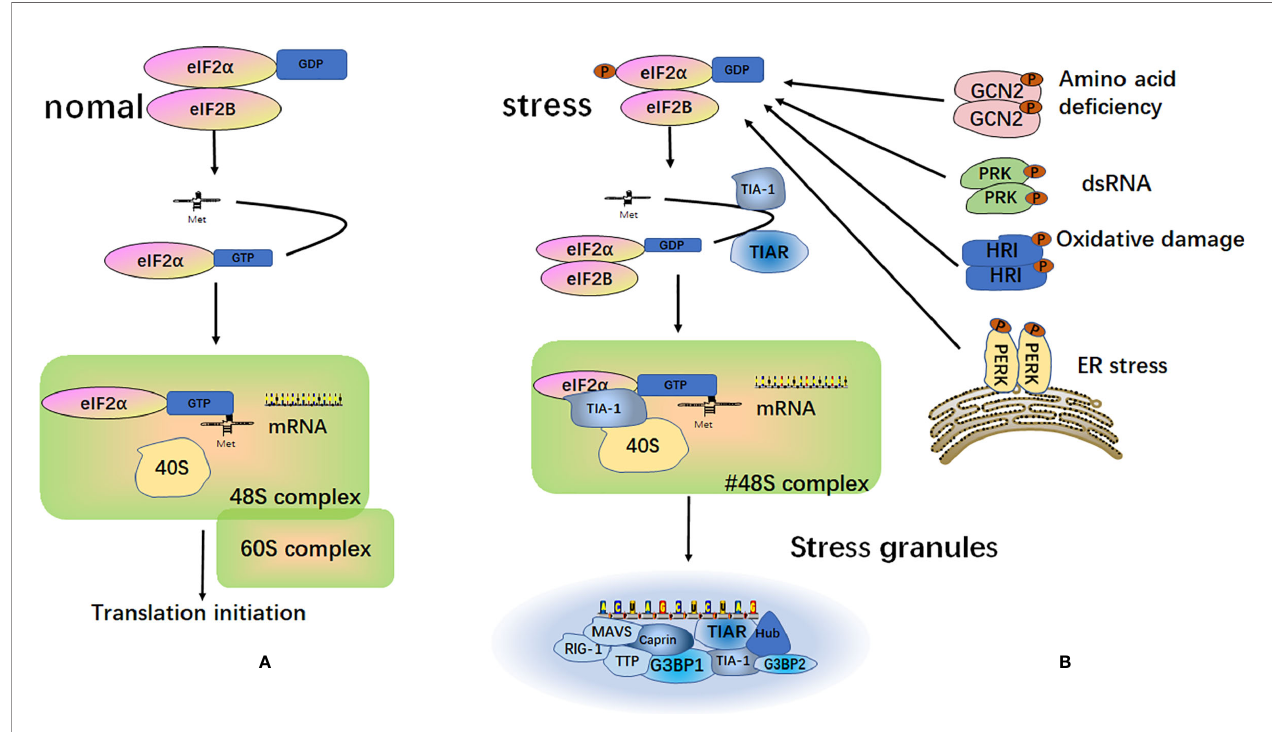
FIGURE 2 | Formation of stress granules. (A) Under normal circumstances, after the separation of the eukaryotic translation initiation factor 2 subunit alpha (eIF2 a ) and eukaryotic translation initiation factor 2B (eIF2B), eIF2 a and tRNA Met form a ternary complex called eIF2-GTP-tRNA Met . This complex binds to mRNA and the 40S and 60S ribosomal subunits to participate in the process of translation; (B) Under different external stimulus conditions, four kinases can be activated to induce phosphorylation of the a subunit of eIF2. The phosphorylated state of eIF2 is stabilized by binding to eIF2B. This binding prevents eIF2B from catalyzing GDP into GTP. This reduces the level of eIF2-GTP-tRNA Met ternary complex and does not allow the formation of a functional 48S initiation complex. Instead, a non-classical 48S initiation complex is produced under the action of TIA-1 and TIAR. This complex cannot recruit the 60S ribosomal subunit to participate in translation, but it is recruited into the stress